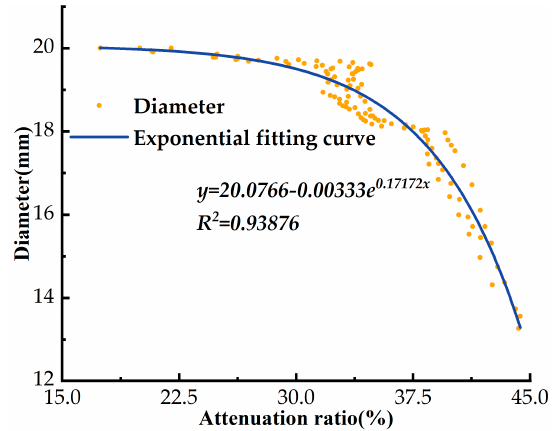
Figure 14. Diameter-energy attenuation ratio curve at bolt necking position.